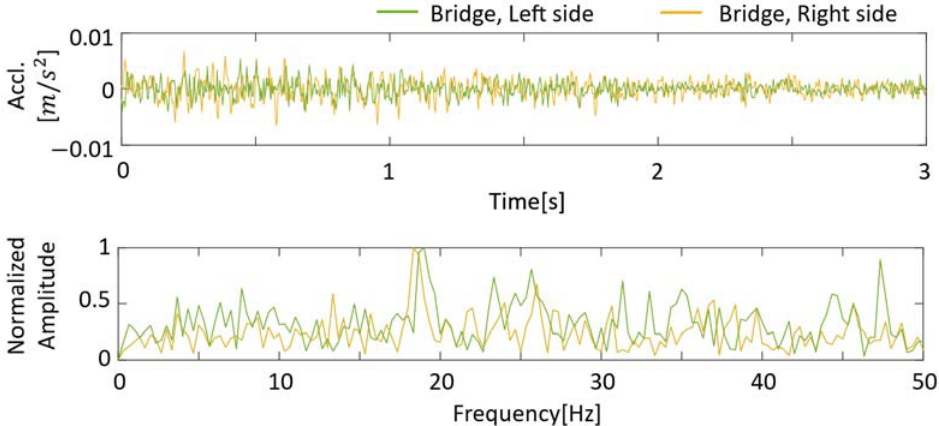
Figure 6. Free-vibration response of the Matsumi Bridge in both the time and frequency domain .